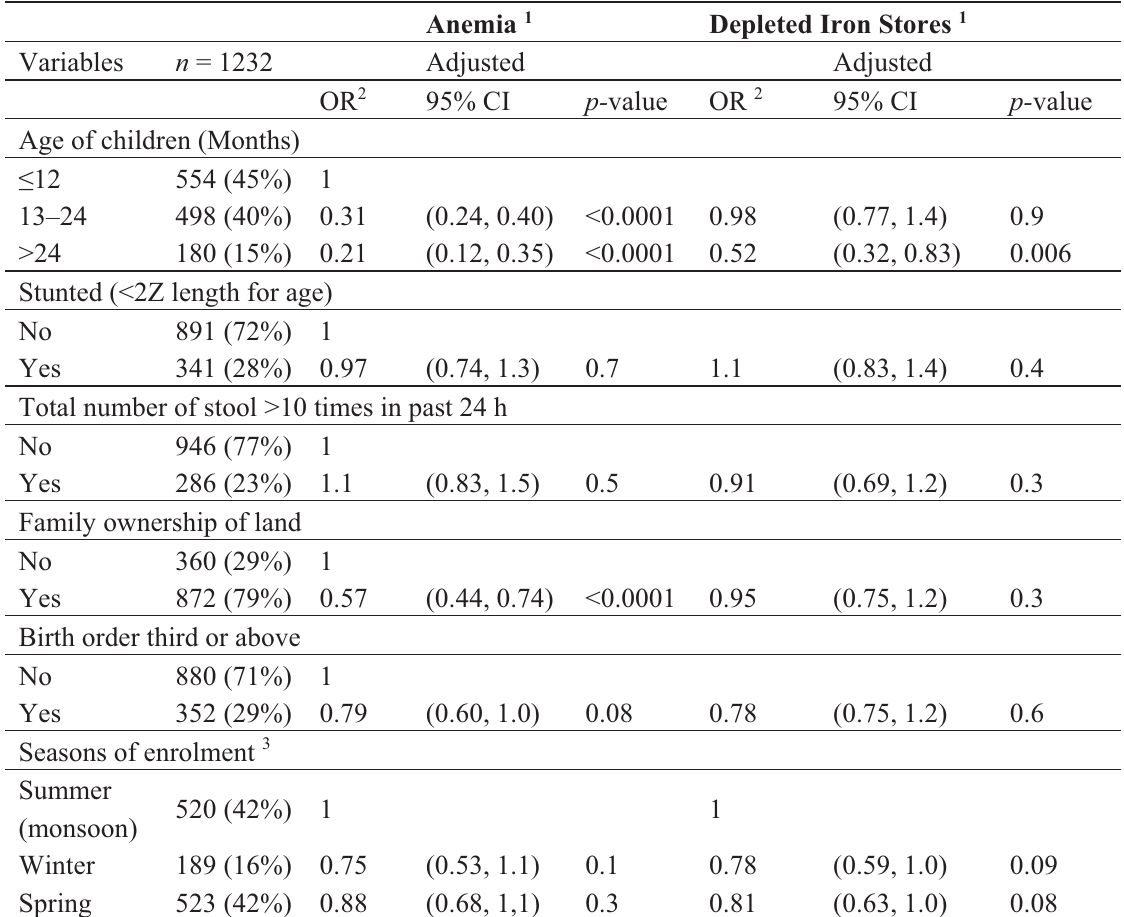
Table 3. Multiple logistic regression for the association of age and nutritional status of children and socio-demographic characteristics with anemia and iron deficiency among children aged 6 – 35 months in Bhaktapur,